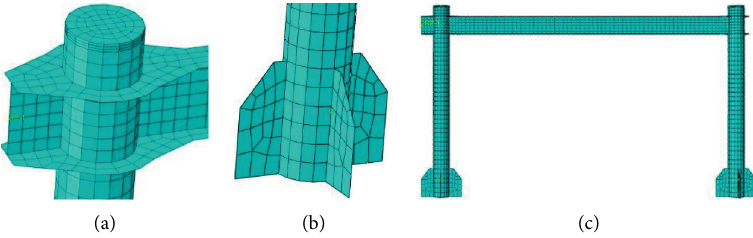
Figure 3: Solid finite element model. (a) Joint. (b) Column foot. (c) Frame.